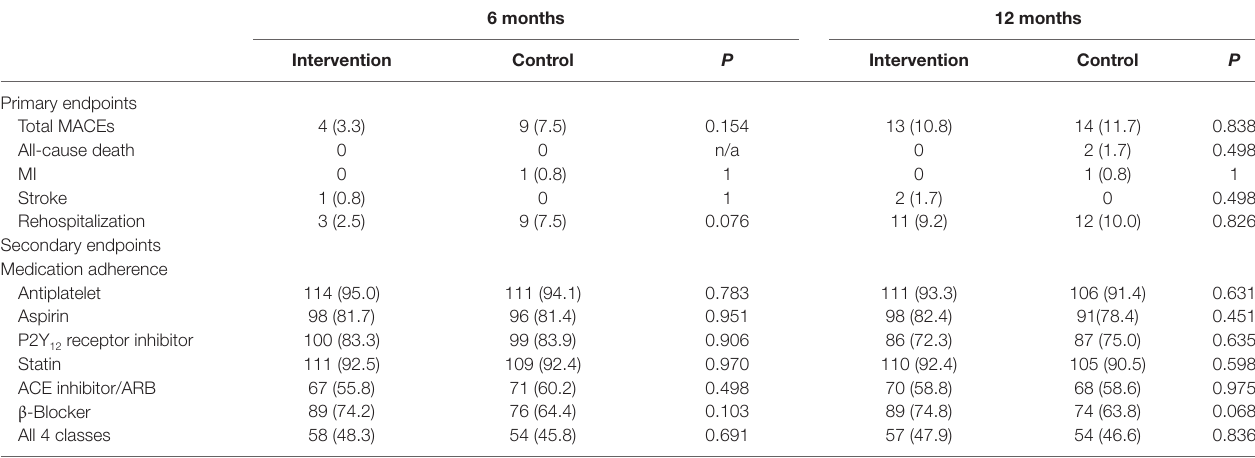
TABLE 2 | Comparison of primary and secondary endpoints in the two groups (within 6 and 12 months after